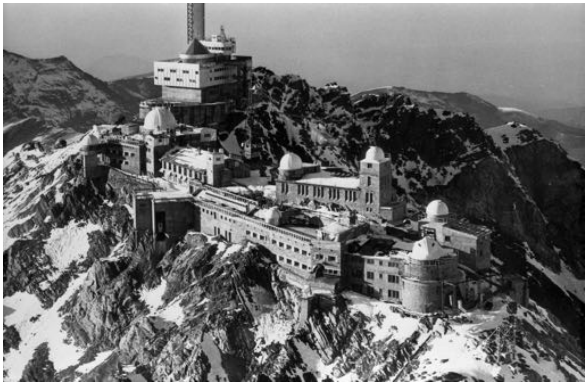
Figure 1. A view from the Observatoire du Pic du Midi in the late 70’s taken from a helicopter